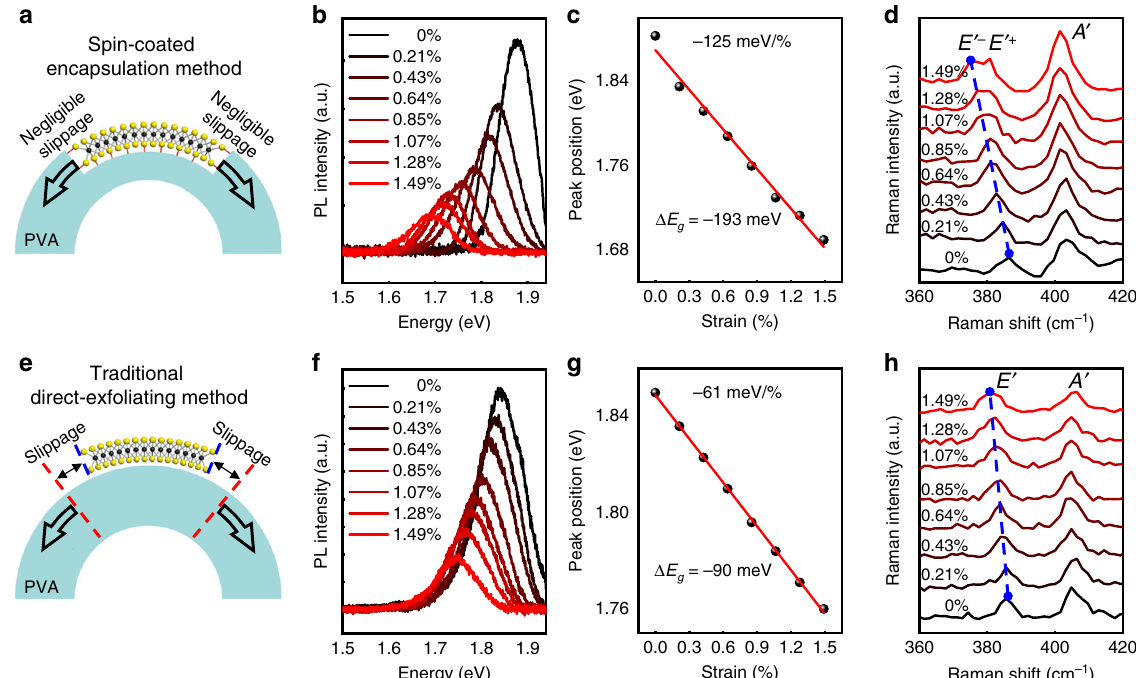
Fig. 2 Bandgap modulation of monolayer MoS 2 using uniaxial tension strain. a – d PL and Raman spectrums under different mechanical strain using spin- coated PVA encapsulation method. b PL spectrum under different tension strain. c With applying tension strain up to 1.49%, large bandgap modulation Δ E g of ~193 meV is observed with a highest modulation ef fi ciency of 125 meV/% using linear fi tting (red line). d Raman spectrum under different tension strain, and the E ′ - peak shows a red shift of 11.1 cm − 1 with an average slope of about 7.4 cm − 1 /% strain when strain value reaches 1.49%. e – h PL and Raman spectrums under different mechanical strain using the traditional direct exfoliating method. f PL spectrum under different tension strain. g With tension strain up to 1.49%, bandgap modulation Δ E g of ~90 meV is observed with a modulation ef fi ciency of 61 meV/% using linear fi tting (red line). The much smaller Δ E g and slope suggest the inef fi cient strain transfer from substrate to MoS 2 using conventional exfoliation approach. h Raman spectrum under different tension strain, and the E ′ peak shows a red shift of 4.8 cm − 1 with an average slope of about 3.2 cm − 1 /% strain when strain value reaches